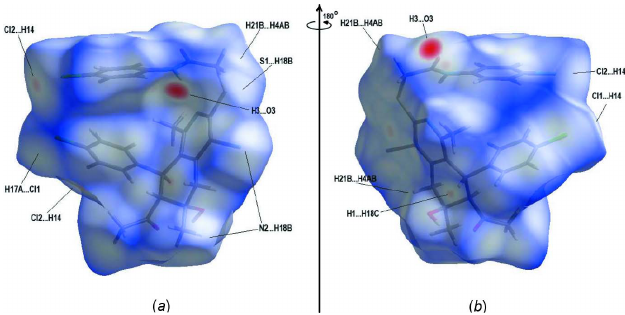
contacts: H (cid:2) (cid:2) (cid:2) H (37.3%; Fig. 5 b ), Cl (cid:2) (cid:2) (cid:2) H/H (cid:2) (cid:2) (cid:2) Cl (17.6%; Fig. 5 c ), O (cid:2) (cid:2) (cid:2) H/H (cid:2) (cid:2) (cid:2) O (11.1%; Fig. 5 d ), C (cid:2) (cid:2) (cid:2) H/H (cid:2) (cid:2) (cid:2) C (10.9%; Fig. 5 e ) and N (cid:2) (cid:2) (cid:2) H/H (cid:2) (cid:2) (cid:2) N (9.7%; Fig. 5 f ). The other contacts are negligible with individual contributions of less than 2.9% and are given in Table 3.